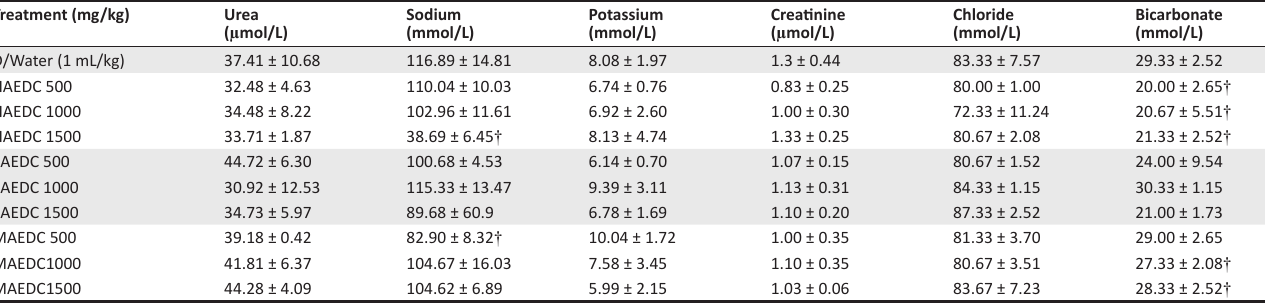
TABLE 4: Effect of n -hexane, ethyl acetate and methanol extracts of Daucus carota aerial part on renal indices of Wistar rats after oral administration for 28 days. Treatment (mg/kg)